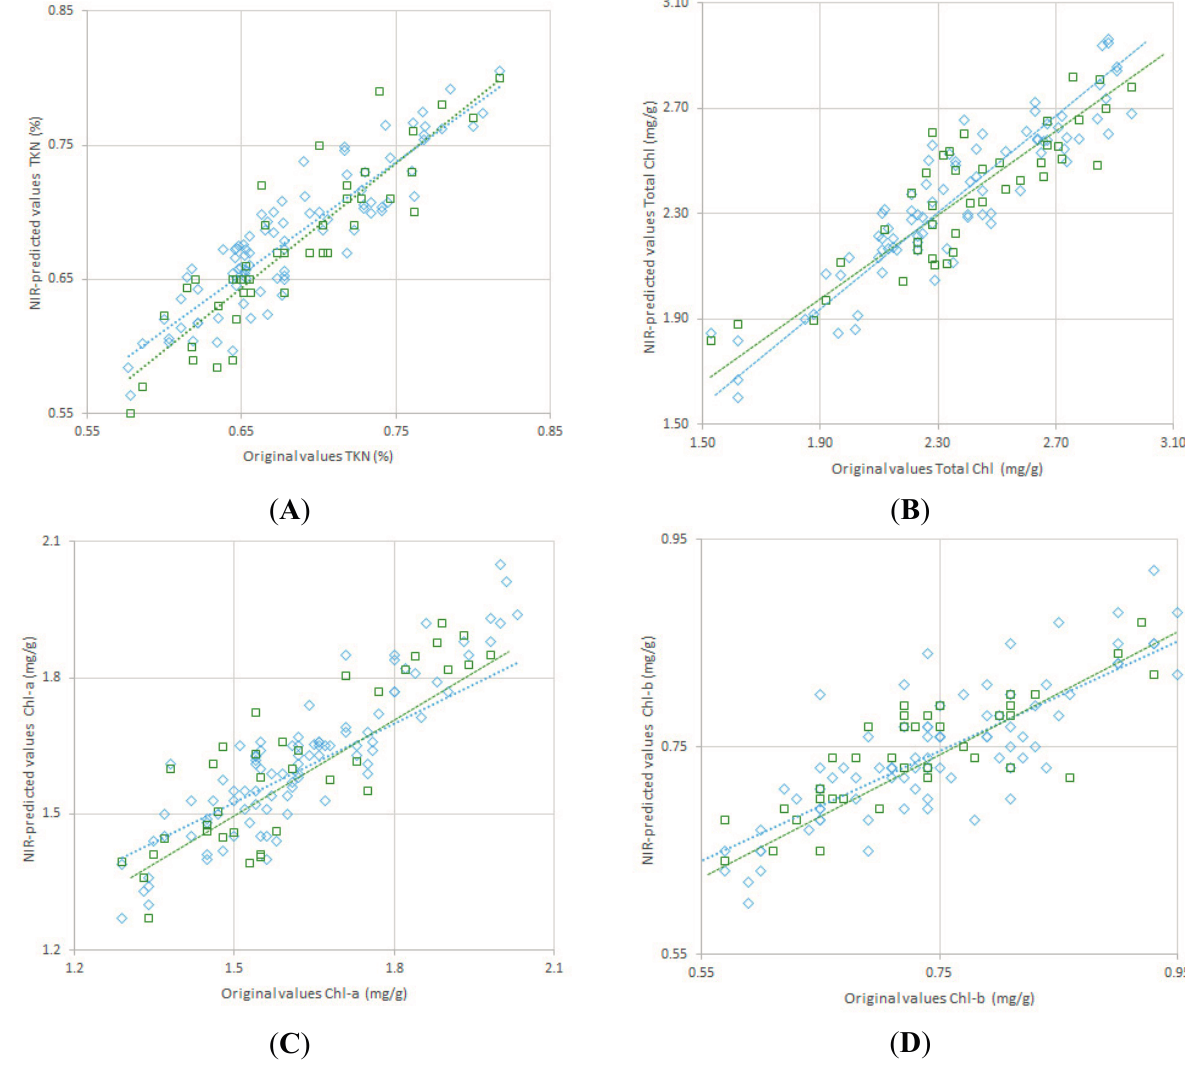
Figure 2. NIR-predicted vs. original values for TKN ( A ); total chlorophyll ( B ); Chl-a ( C ) and Chl-b ( D ). Calibration (open rhombus) and cross-validation (open squares) curves are shown. Concentrations are expressed as % of fresh leaves mass for TKN, and as mg/g of fresh leaves mass for